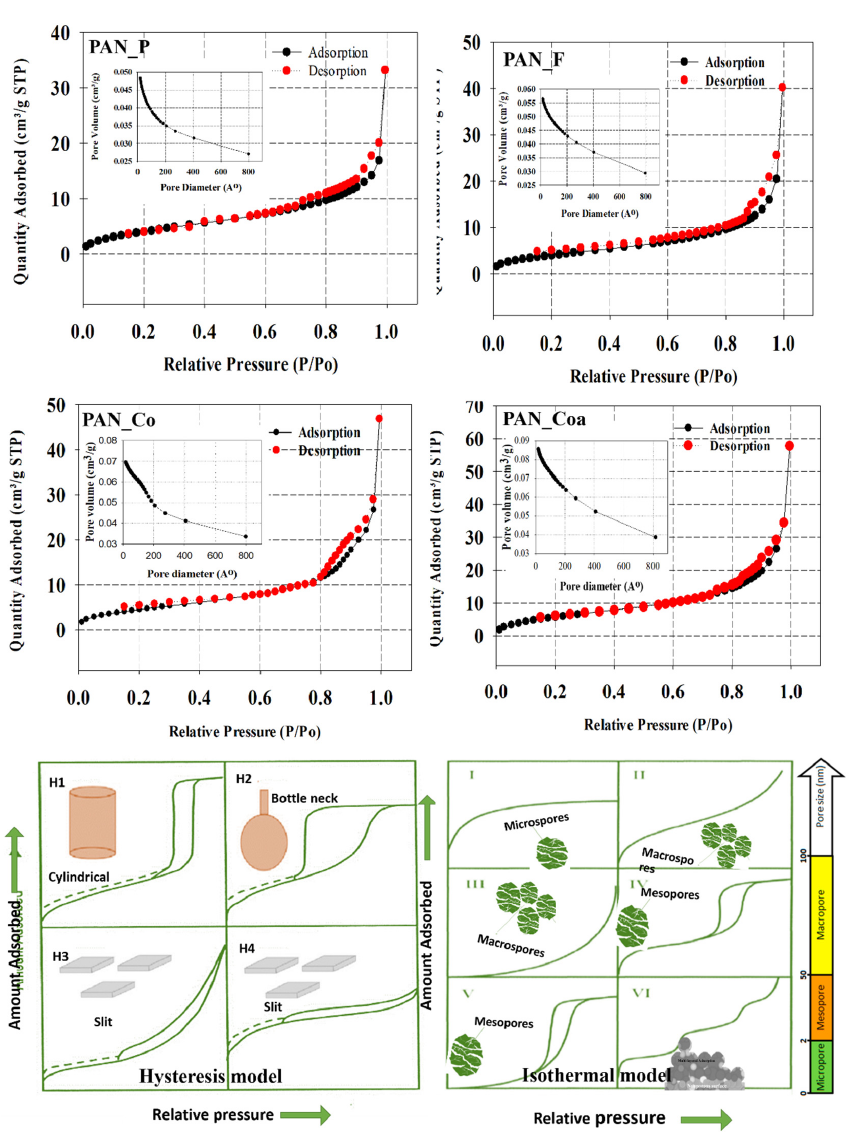
Figure 6. Adsorption-desorption isotherms of the PAN_P, PAN_F, PAN_Co and PAN_Cao NFs membranes under nitrogen atmosphere. IUPAC classified hysteresis and isotherm models.